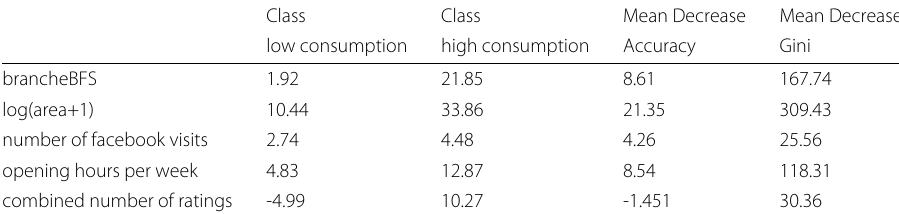
Table 5 Random Forest feature importance scores for the prediction of high consumption enterprises Class Class Mean Decrease low consumption high consumption Accuracy